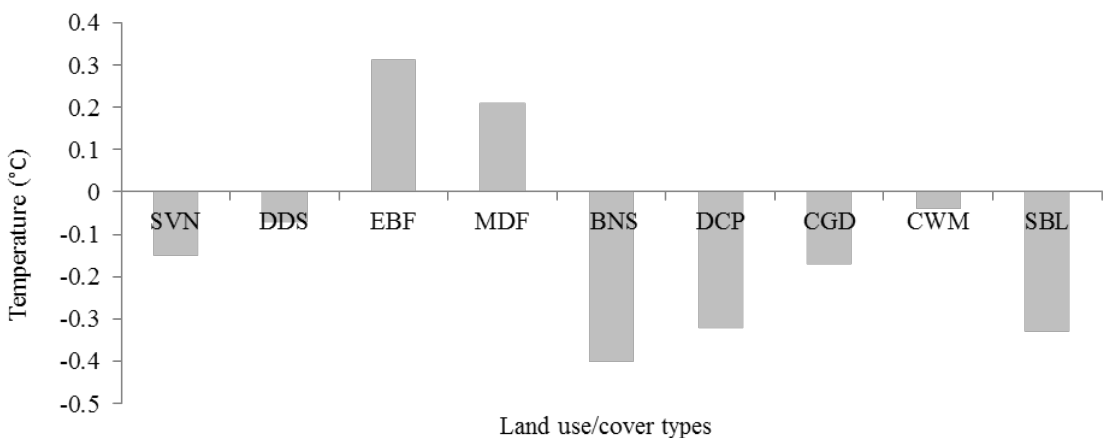
Figure 8. Change of the monthly average temperature due to land conversion from other types to Irrigated Cropland and Pasture in summer in